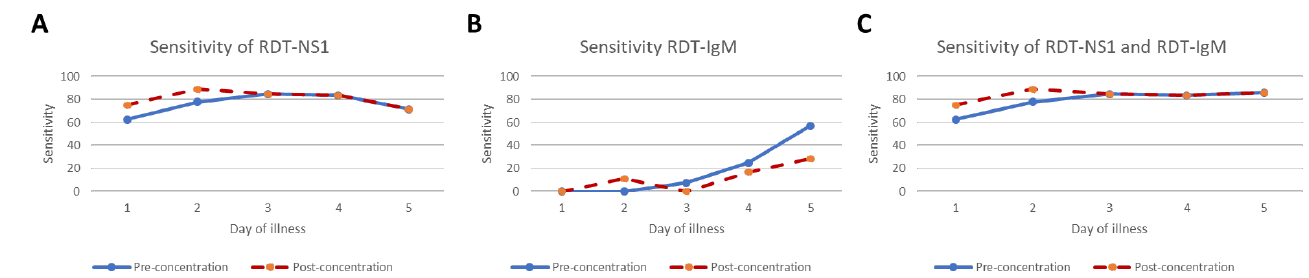
Figure 2. The sensitivity of dengue RDT for NS1 ( A ), IgM ( B ) and combined NS1 and IgM ( C ) by day of illness for both pre-and post- concentration are plotted in the graph. The sensitivity on Day 6 was not estimated due to the small sample size.